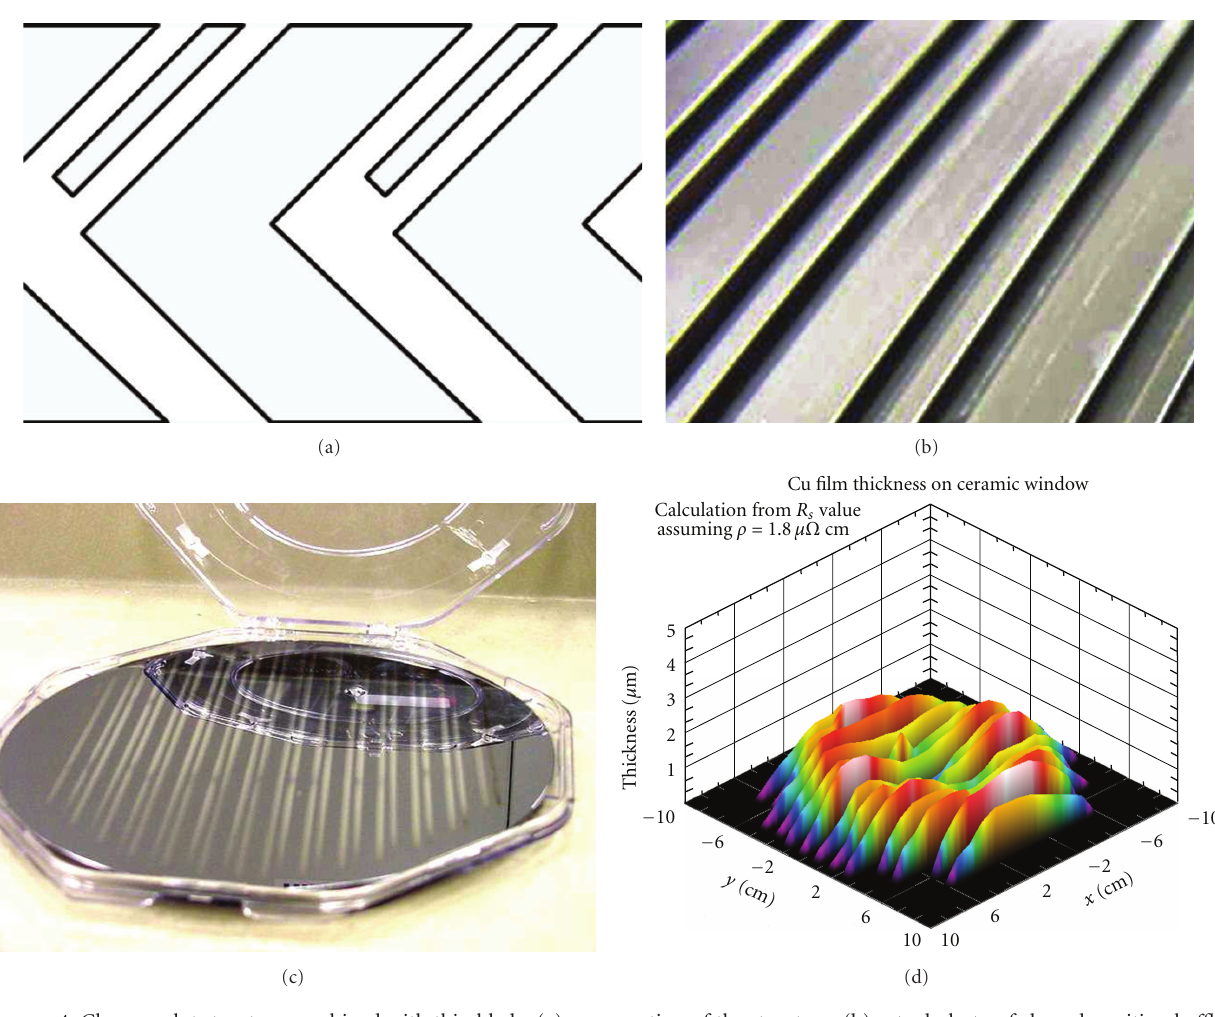
Figure 4: Chevron slot structure combined with thin blade: (a) cross-section of the structure, (b) actual photo of clean deposition ba ffl e- side exposed to the metal containing plasma, (c) cumulative deposit traces on the testing wafer, and (d) actual profile and thickness of the cumulative deposition on the wafer (calculated from sheet resistance of the metallic film).